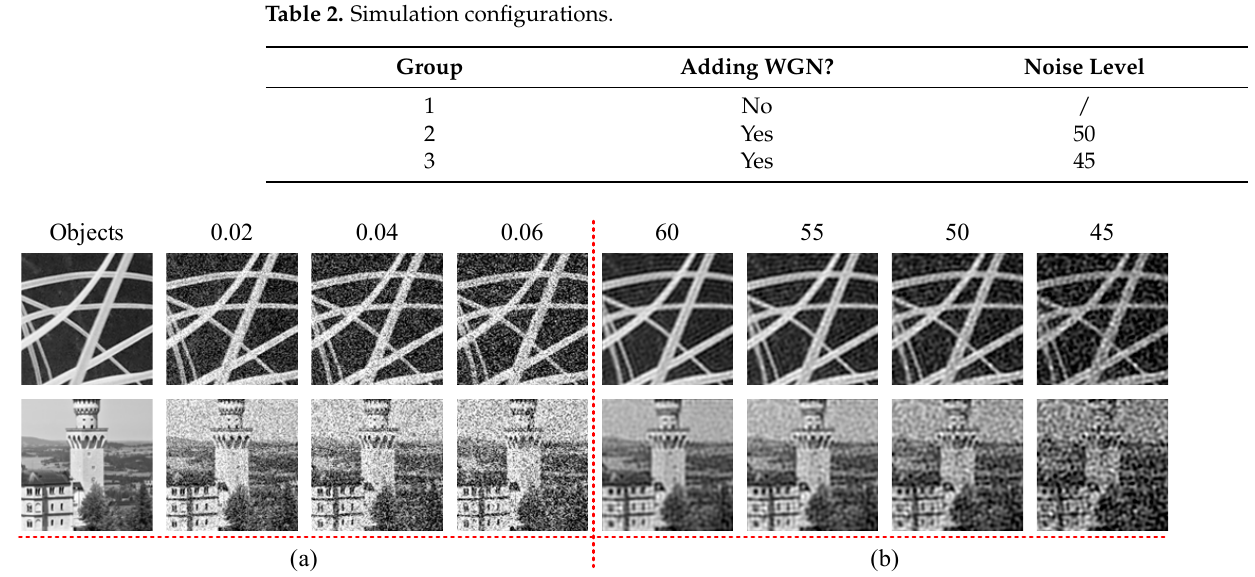
Figure 2. ( a ) Objects for simulations and simulated images with WGN at variances of 0.02, 0.04, and 0.06. ( b ) Images restored by FSPI at the noise levels of 60, 55, 50 and 45. Table 1. Pattern types and methods used for simulations.